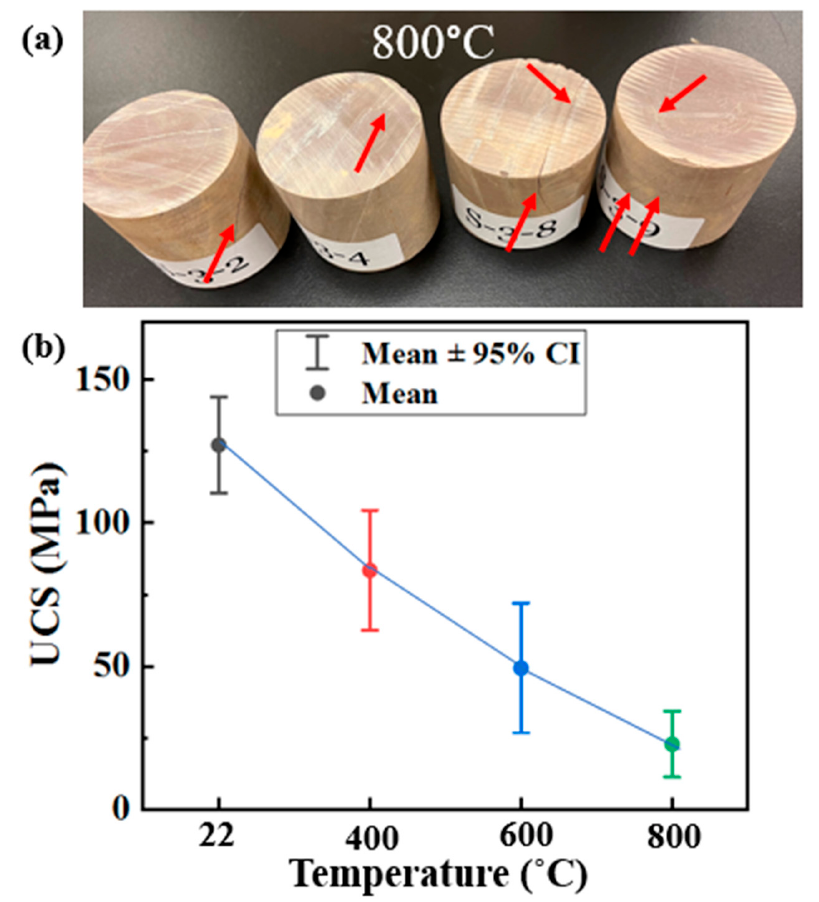
Figure 16. ( a ) Crack observation for the samples heated at 800 °C, ( b ) UCS of the studied samples at different temperature. different